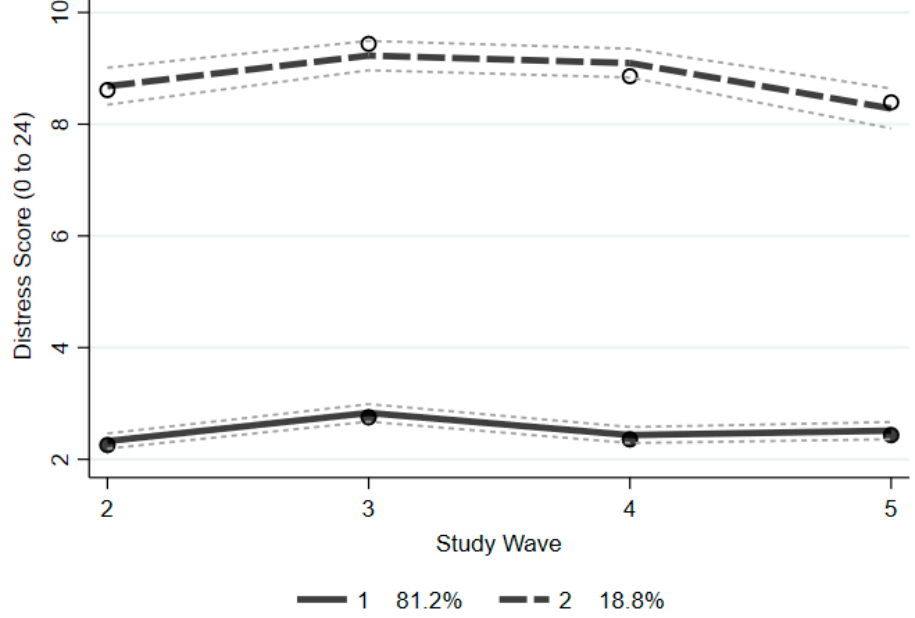
Figure 2. Trajectory patterns of psychological distress over four waves.